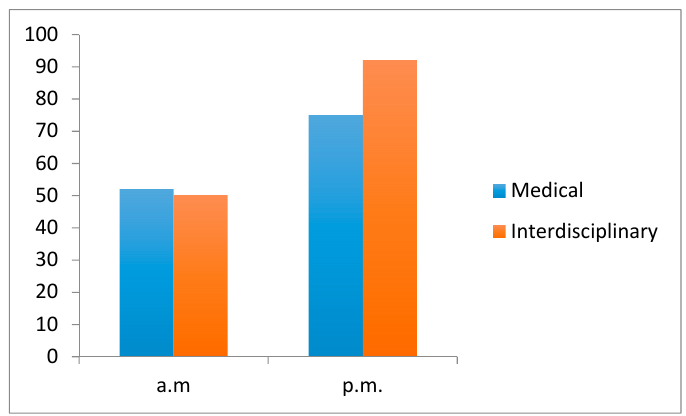
Figure 2. Clinical Team Performance. Performance scores increased by 47% ( p < 0.05) with the addition of drama students.